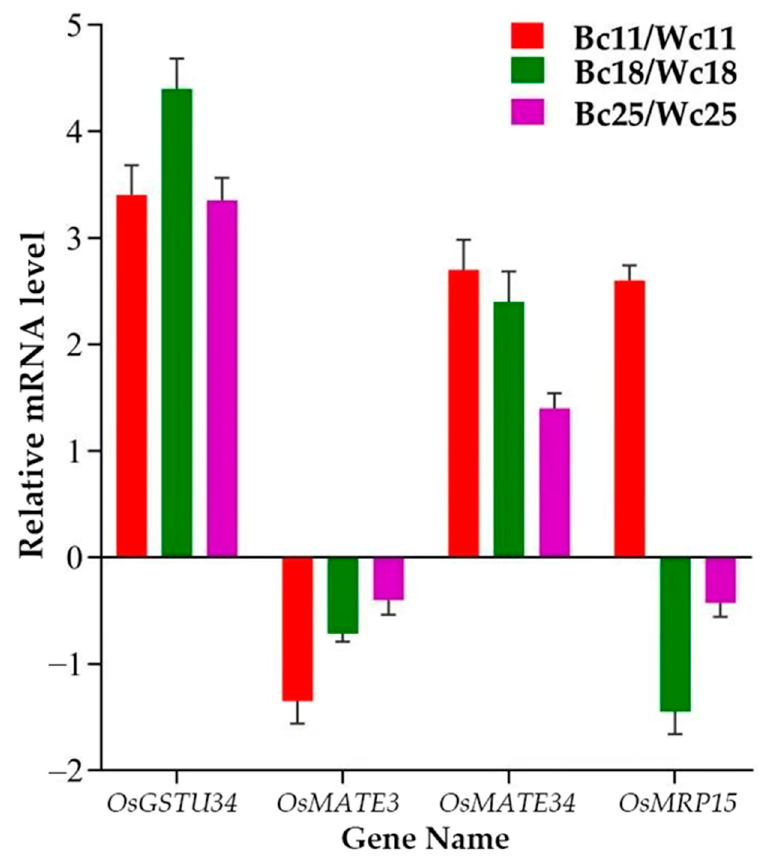
Figure 9. Real-time quantitative PCR validation of transcriptome data for four selected DEGs in all samples. The data were obtained from three independent repeats.